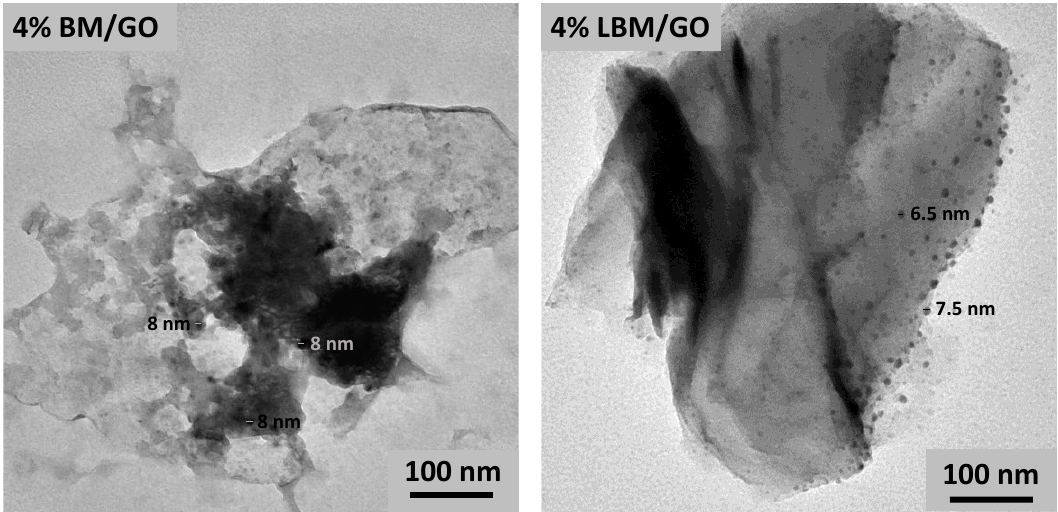
Figure 6. Transmission electron microscopy analysis of 4% BM/GO and 4% LBM/GO composites.